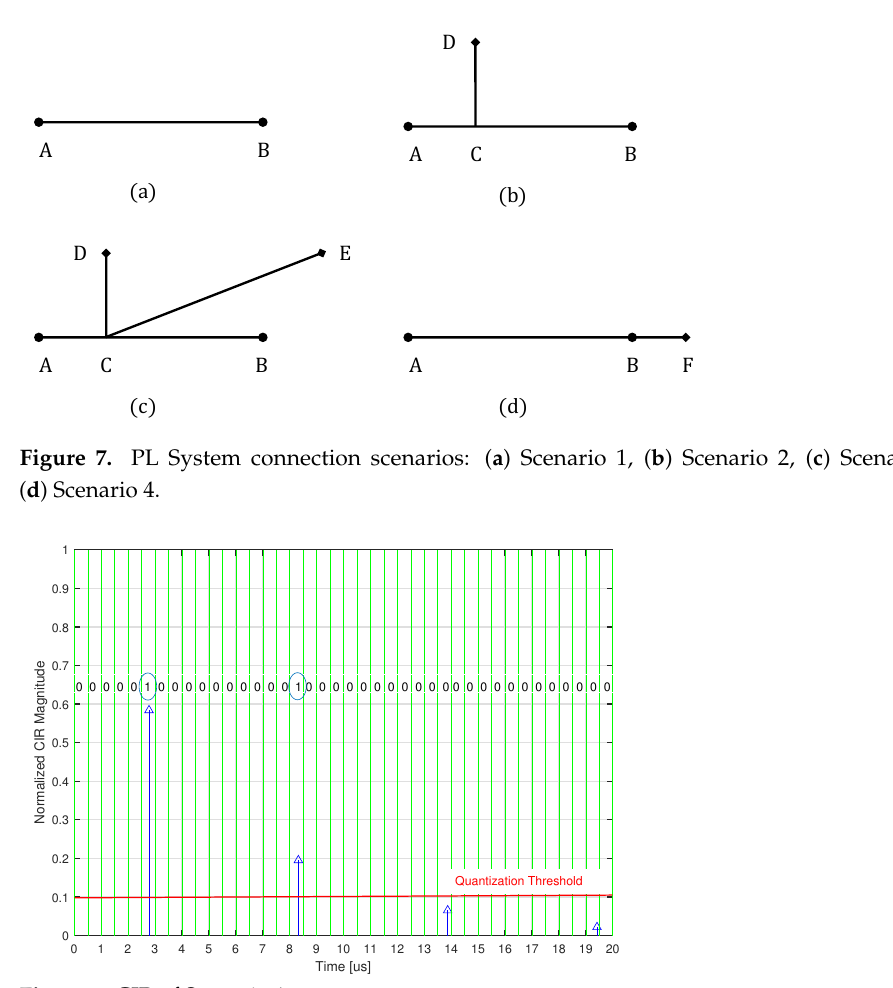
Figure 8. CIR of Scenario 1.